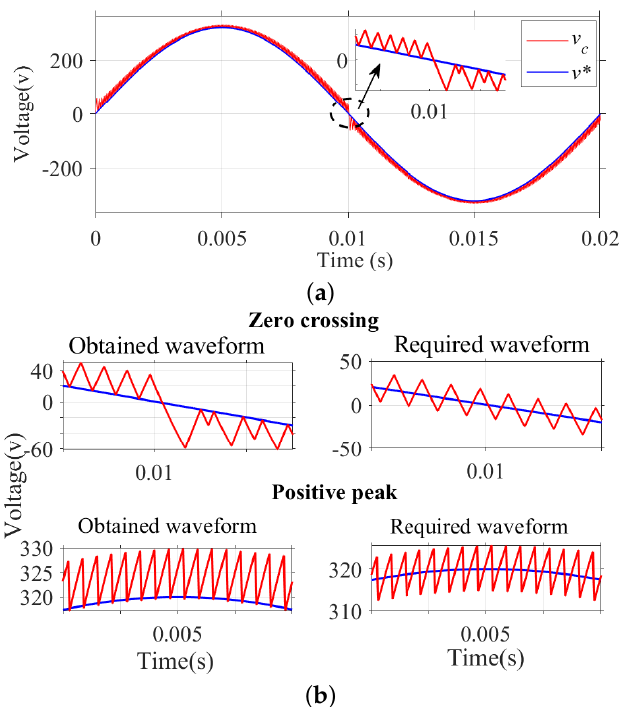
Figure 5. ( a ) Variation of v c , v ∗ over one cycle of reference signal. ( b ) Variation of v c along with their ideally required waveshape near zero crossings and near the positive